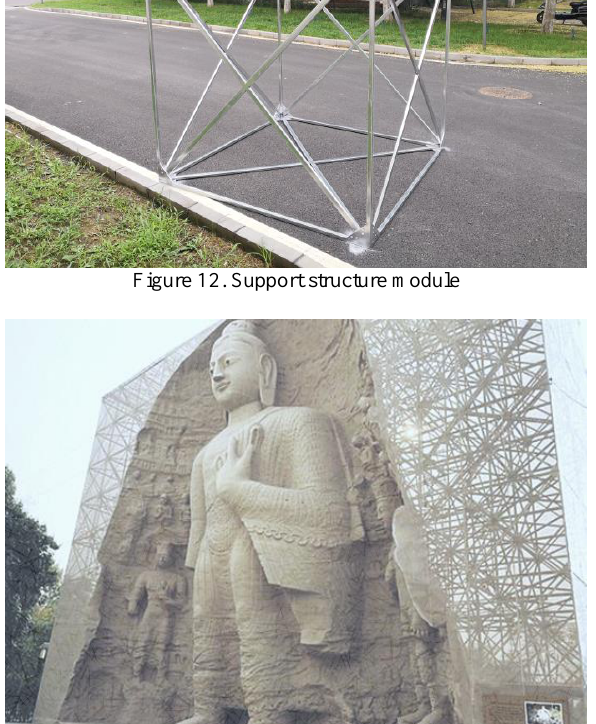
Figure 13. Reproduction of the The 18th Cave of Yungang